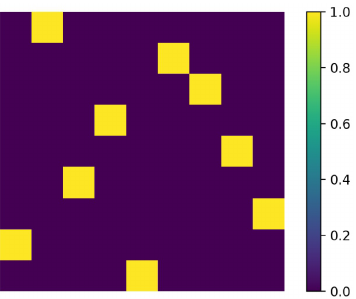
FIG. 3. The action of the M (cid:9) R map on a random-seed unitary of order 9. The map converges to 2-unitary permutation matrix (up to phases). The only nonzero element in each row or column is shown by a yellow